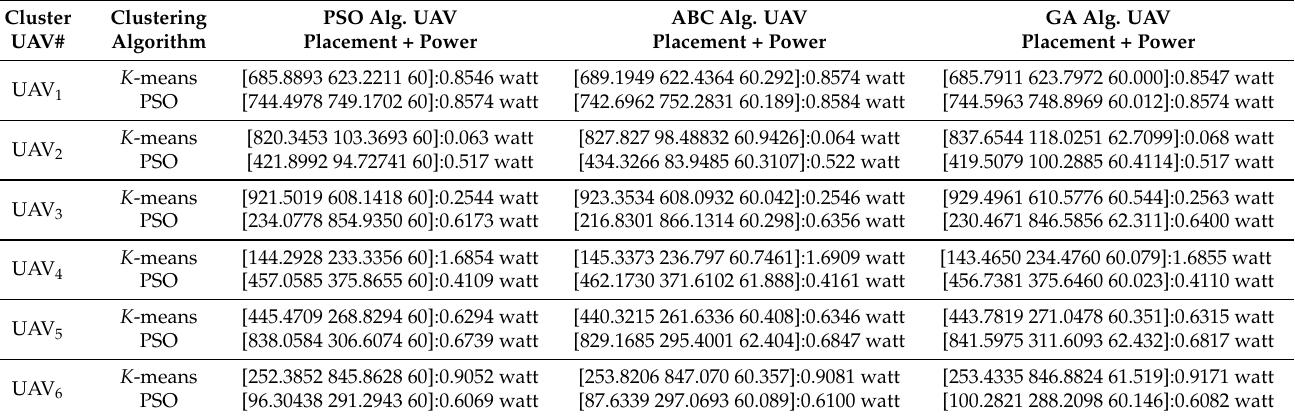
Table 3. Simulation results of the power-efficient algorithm for uniform distribution